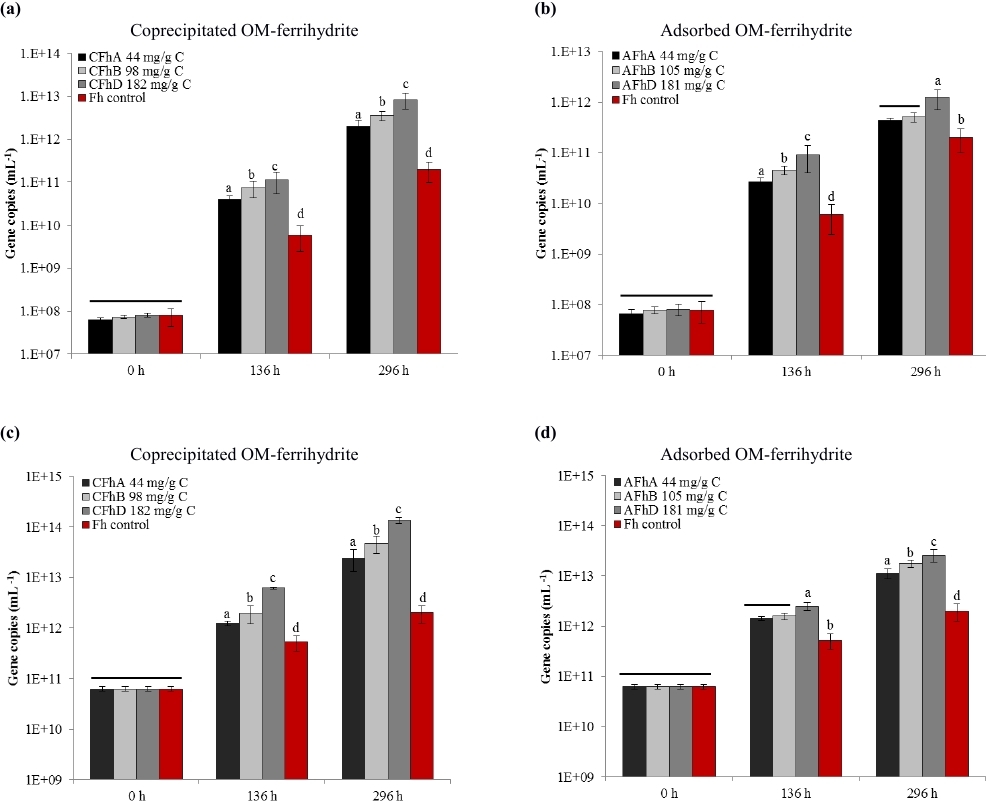
Figure 2. Abundances of bacterial 16S rRNA gene in subsamples taken from ferrihydrite incubations containing either S. oneidensis MR-1 or peat microbial consortia extracted from peat at T 0 (0h), T middle (136h), and T endq (296h). Bars represent mean abundances of triplicate samples from S. oneidensis MR-1 incubations with coprecipitated OM–ferrihydrite (CFh) (a) or adsorbed OM–ferrihydrite (AFh) (b) and peat microbial consortia incubations with coprecipitated OM–ferrihydrite (CFh) (c) or adsorbed OM–ferrihydrite (AFh) (d) . Each sample was measured in triplicate qPCR reactions with applicable standard deviations. One-way ANOVA was applied to compare individual data sets for statistically significant differences between ferrihydrite incubations. Different letters (a, b, c, d) indicate statistically significant differences, while horizontal black lines indicate non-significant